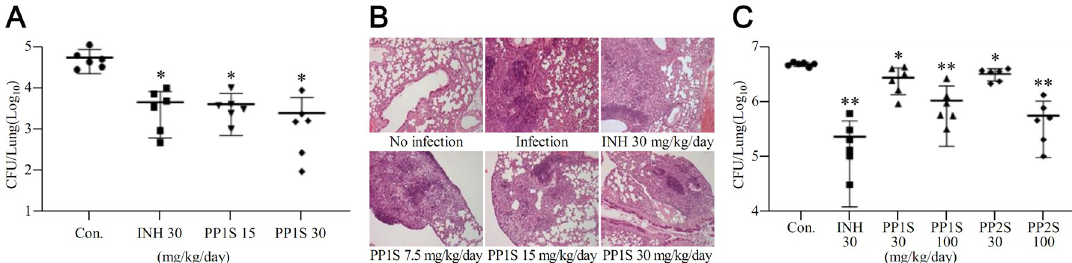
Fig 4. Efficacies of PPs in a BALB/C mouse model of pulmonary tuberculosis. After 4 weeks of low-dose infection followed by 4 weeks of oral administration of PP1S, (A) bacterial load in the lung was measured through CFU test, and (B) granuloma area was analyzed after HE staining (magnification, × 100). (C) After 10 days of high-dose infection followed by oral administration of PP1S or PP2S for 2 weeks, bacterial load in the lung was measured through the CFU test. INH was used as a positive control at 30 mg per kg body weight. Data are expressed as mean ± SD and Student t test was used to compare groups ( � p < 0.01, �� p < 0.001). Images of Ziehl– Neelsen staining in a high-dose infection model are presented in Supporting information (S3 Fig). CFU, colony-forming units; HE, hematoxylin–eosin; INH, isoniazid; PP, methyl (S)-1-((3-alkoxy-6,7-dimethoxyphenanthren-9-yl)methyl)-5-oxopyrrolidine- 2-carboxylate. Data underlying this Figure can be found in S1